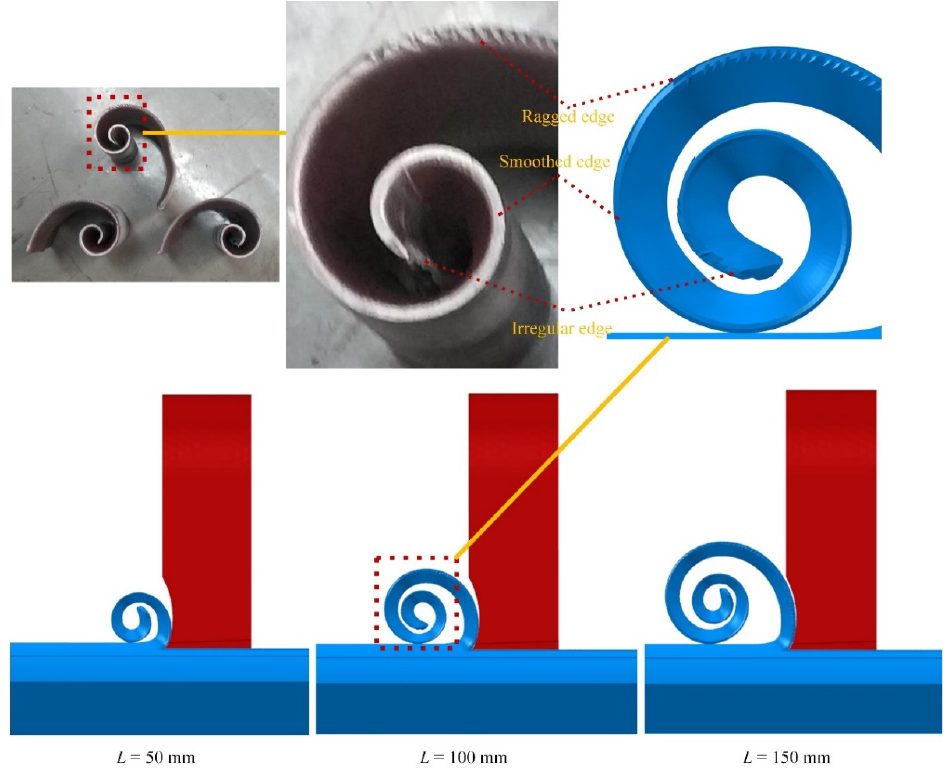
Figure 6. Chip deformation mode comparison of simulation and